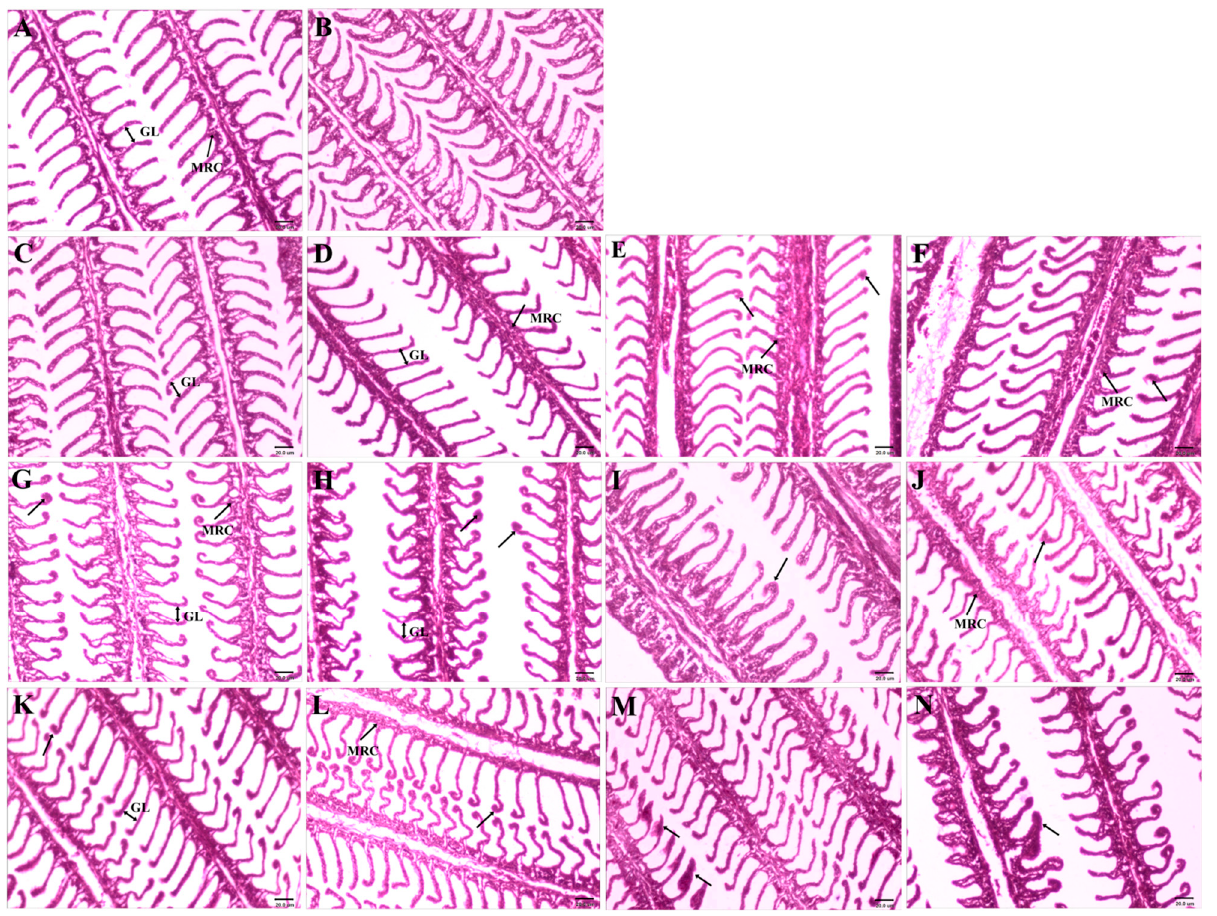
Figure 5. Representative H&E-stained micrographs of the gill structure of the pearl gentian grouper at di ff erent transport temperatures and vibration rates. ( A ) 15 °C, ( B ) 25 °C, ( C ) 24 h—5 °C, ( D ) 24